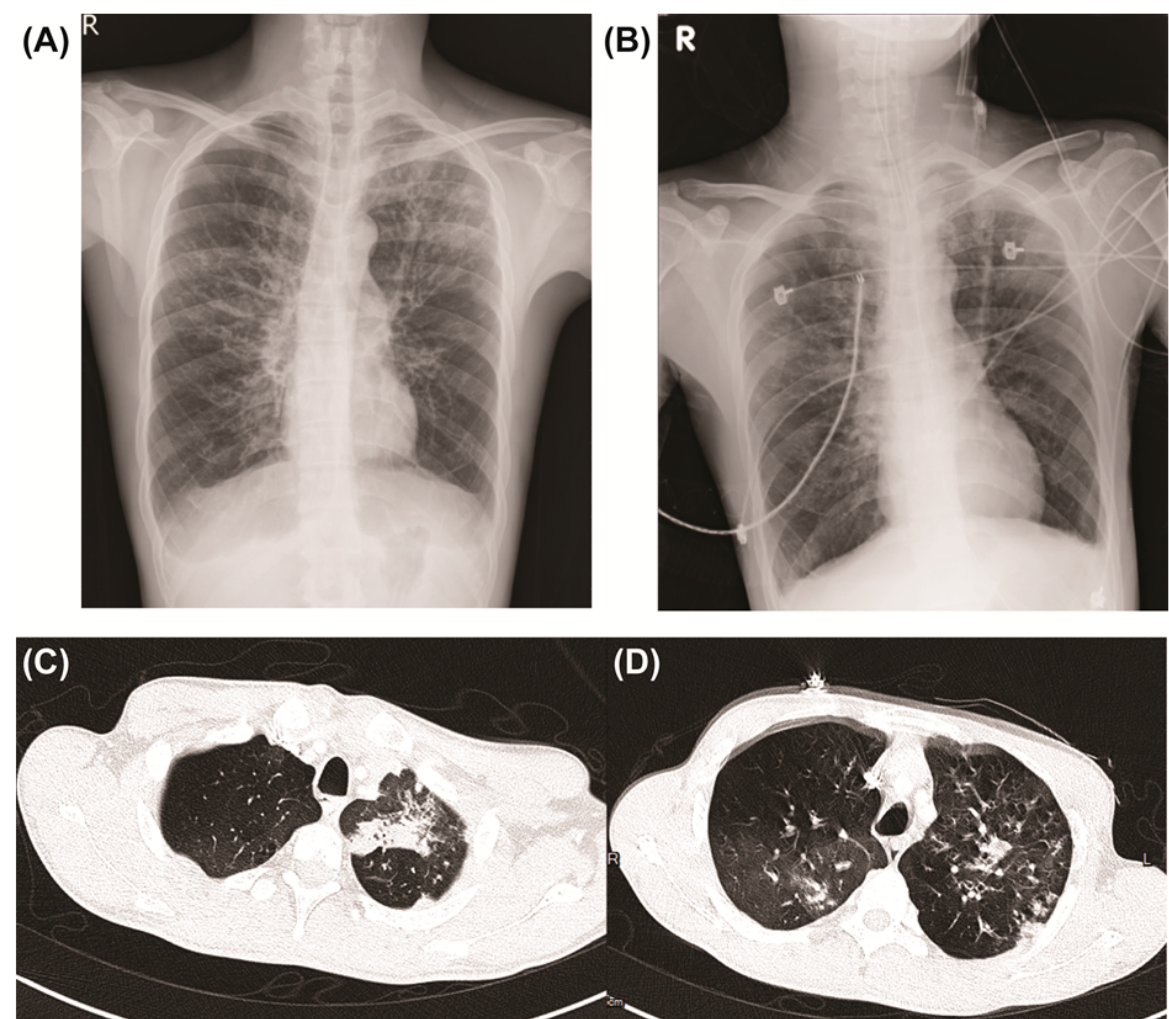
Figure 1. Chest X-ray and computed tomography images. (A,C,D) On the day of admission to our hospital, and (B) after intubation.